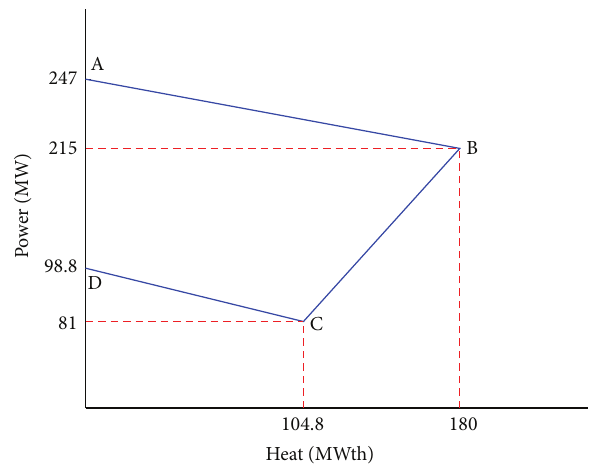
Figure 1: Heat-power feasible operating region for CHP unit 1.